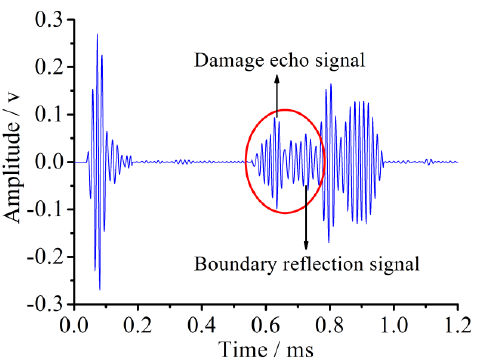
Figure 20. Received signal in the pipe with circumferential damage of 90° at the changed position in the simulation.